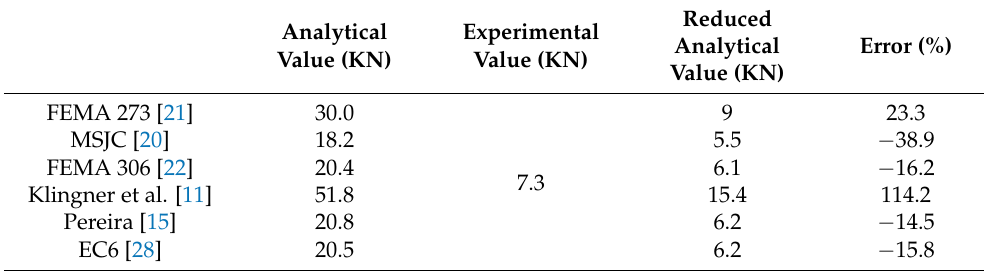
Table 11. Comparison of the experimental and analytical out-of-plane capacity values of the infill walls with openings on the transversal direction of models 2 and 3 after their reduction using the geometrical factor.